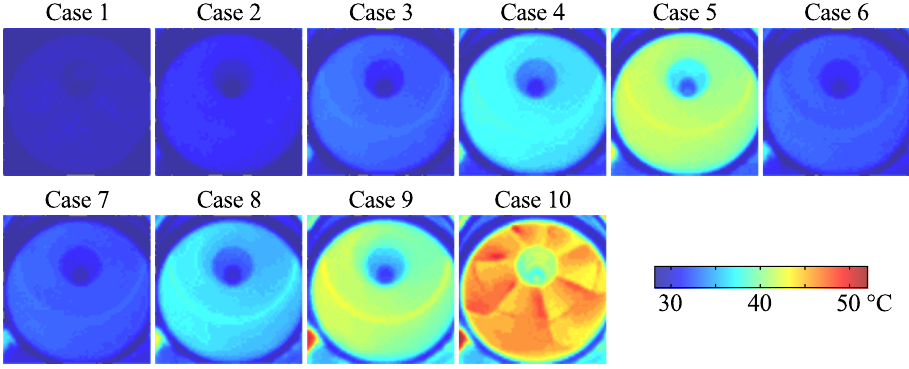
Figure 7. Thermal images of impeller at indicated flow